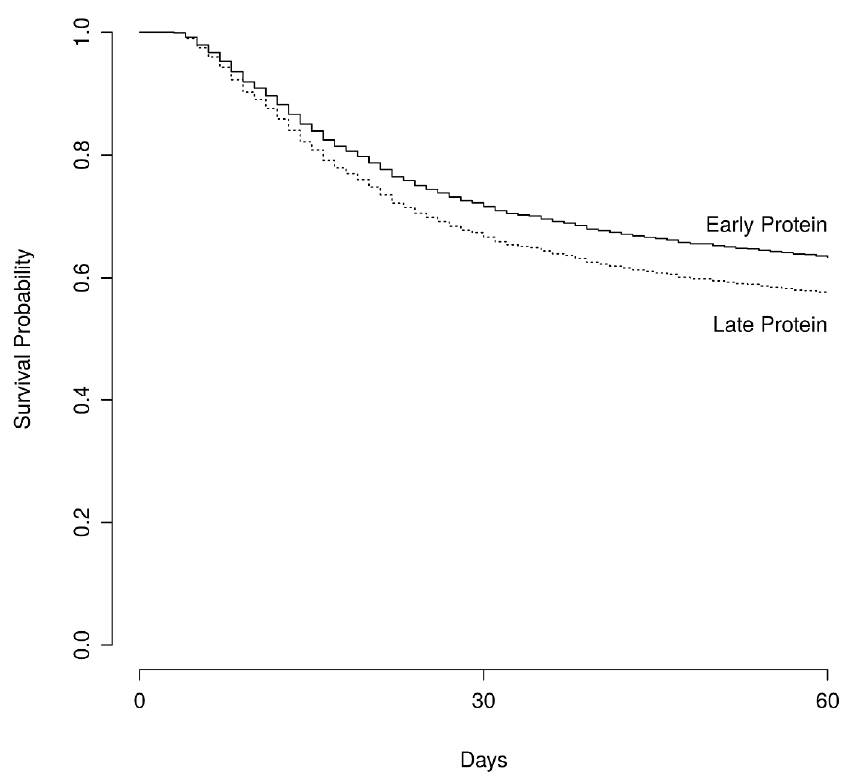
Figure 2. Survival. This figure shows adjusted survival estimates of the survival curves among patients receiving early or late protein. The Hazard Ratio for death was calculated at 0.83 (95%, CI